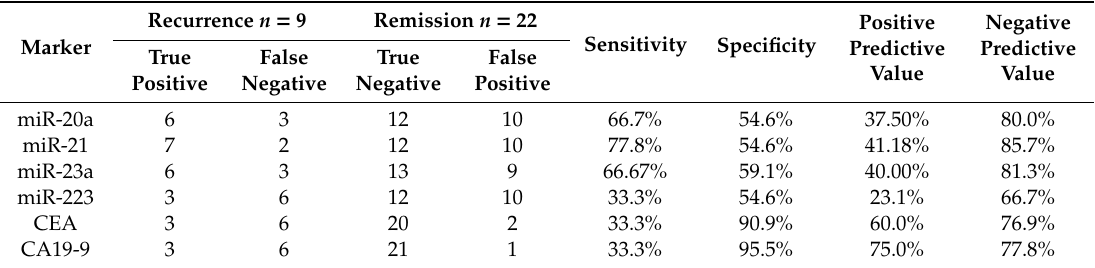
Table 2. The diagnostic ability of markers in relation to the detection of disease recurrence of patients treated by radical surgery.